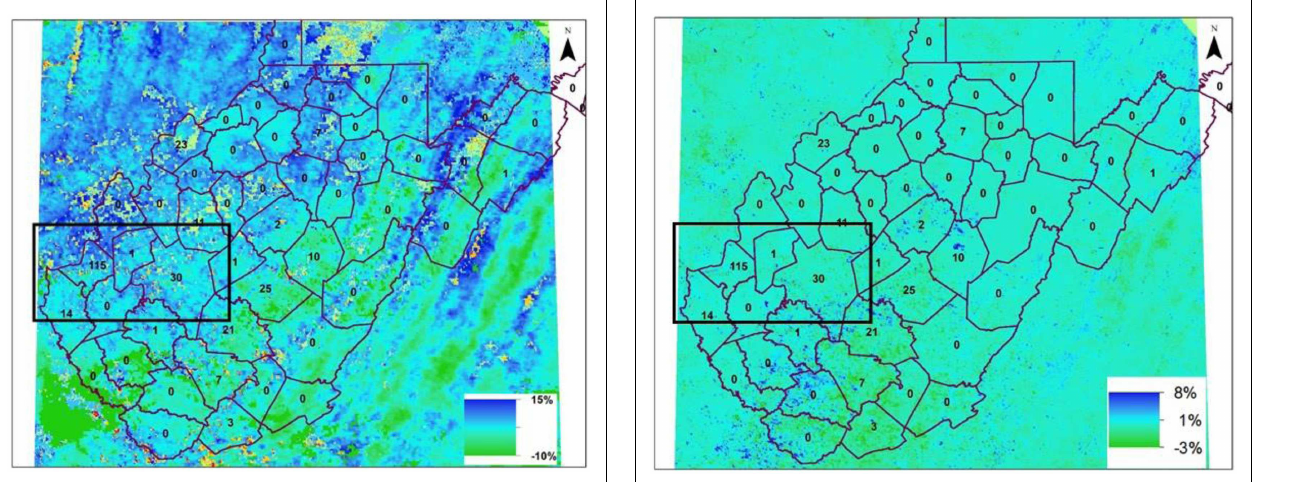
FIGURE 4 | Percentage change in NDVI in July 2012 with respect to July 2011 .The inset numbers on map are theWNV positive mosquitoes in year 2012 in counties ofWestVirginia. (Black box in the figure – 38.6825°N to 37.8788°N; 82.5844°W to 81.0955°; and include Cabell and Kanawha counties